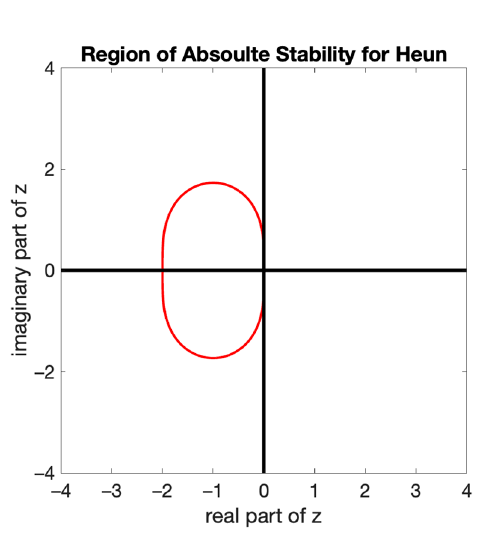
Figure 2. Global absolute stability region for Heun’s method .